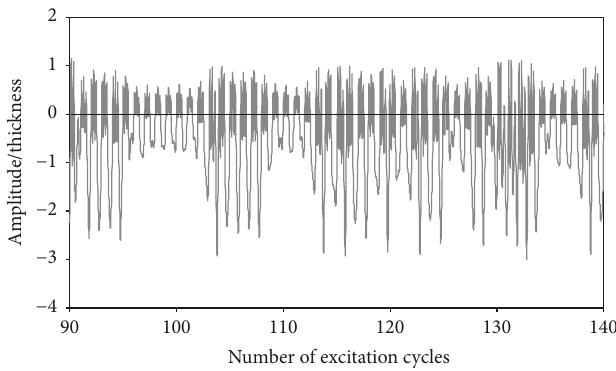
(a) Time history for the superharmonic case ( ℎ = 2 mm, 𝐿 𝑥 = 0.5 m, 𝐿 𝑧 = 0.3 m, 𝐵 = 0.4 m, 𝜉 = 0.02 , 𝑤 𝑐 = 1 mm, 𝜅 = 4 , 𝜔 = 0.87𝜔 𝑜 )